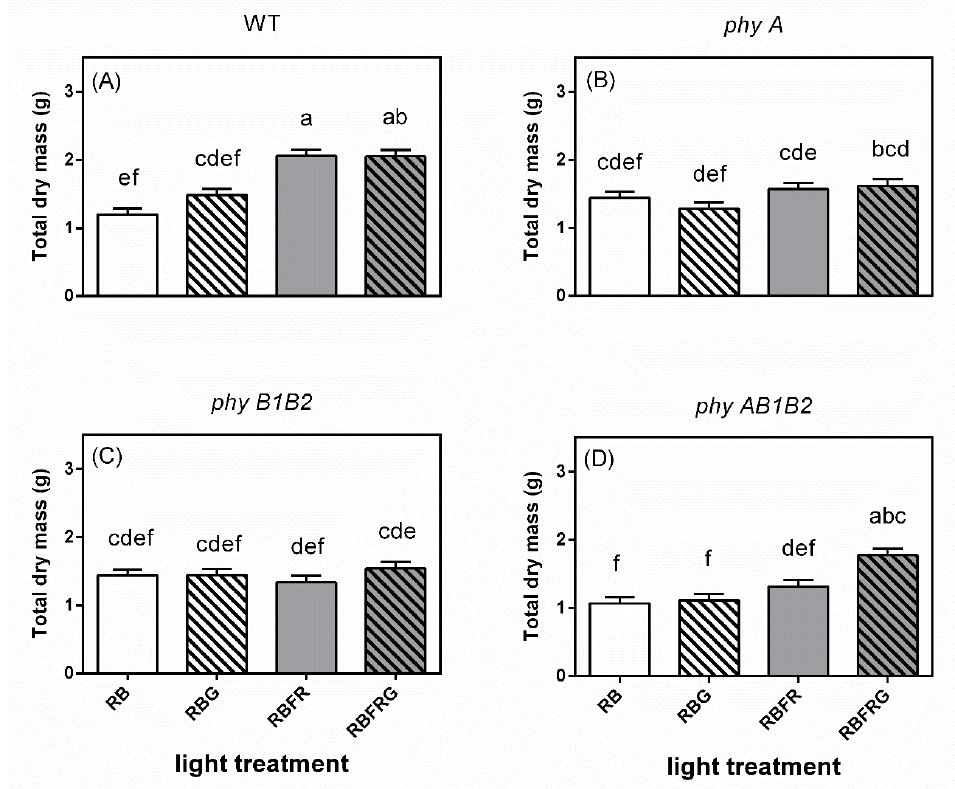
Figure 4. Effect of partial (20%) substitution of red/blue (RB; 3:1) with green (G) light in the presence or absence of far-red light (FR) on the total dry mass of tomato plants 21 days after treatment. Four genotypes were studied: ( A ) WT (Moneymaker, wild-type), ( B ) phyA (phytochrome A-deficient), ( C ) phyB1B2 (phytochrome B1- and B2-deficient), and ( D ) phyAB1B2 (phytochrome A-, B1-, and B2-deficient). Light treatment and genotype did not significantly interact ( p = 0.082), although the effects of light treatment and genotype were significant ( p < 0.001 and p = 0.01, respectively). Lower case letters indicate significant differences among the combinations of light treatment and genotype ( p = 0.05), thus also allowing comparisons between panels ( A – D ). Data presented are averages, with the SE based on 5 blocks ( n = 5), each containing 3 replicate plants (Exp1).